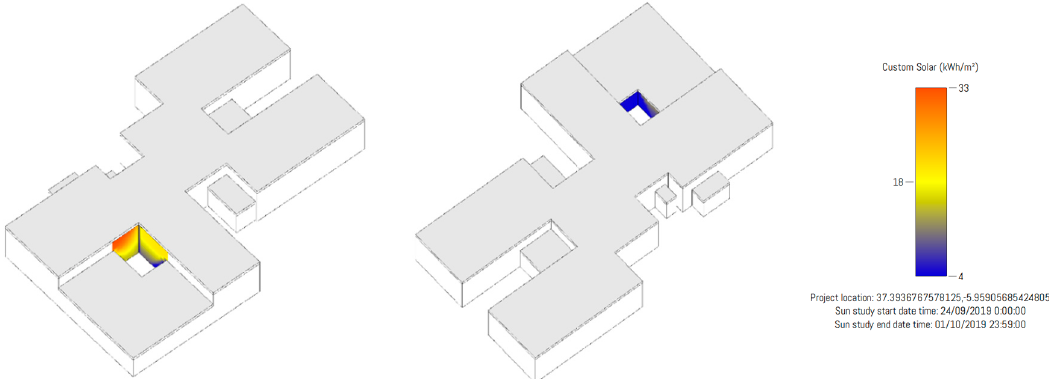
Figure 9. Case study 2: Cumulative insolation from 24th September to 1st October. Table 3. Cumulative direct solar radiation in both courtyards.